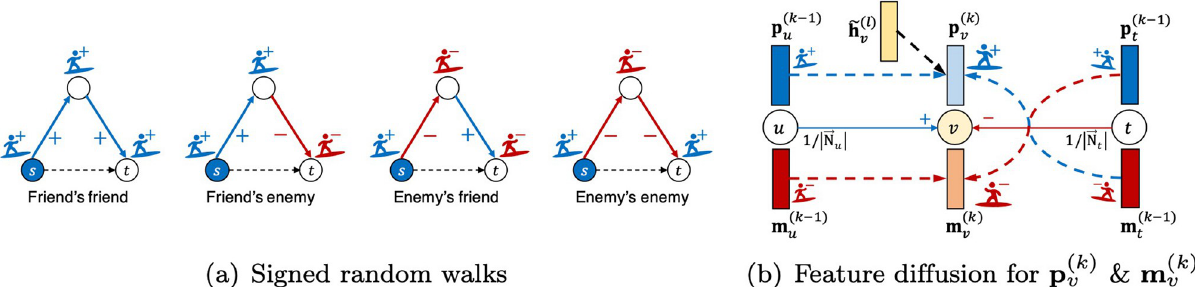
Fig 2. Feature diffusion by signed random walks in S ID N ET . (a) Signed random walks properly consider edge signs. (b) The positive and the negative feature vectors p ð k Þ and m ð k Þ are updated from the previous feature vectors and the local feature vector ~ h ð l Þ v v